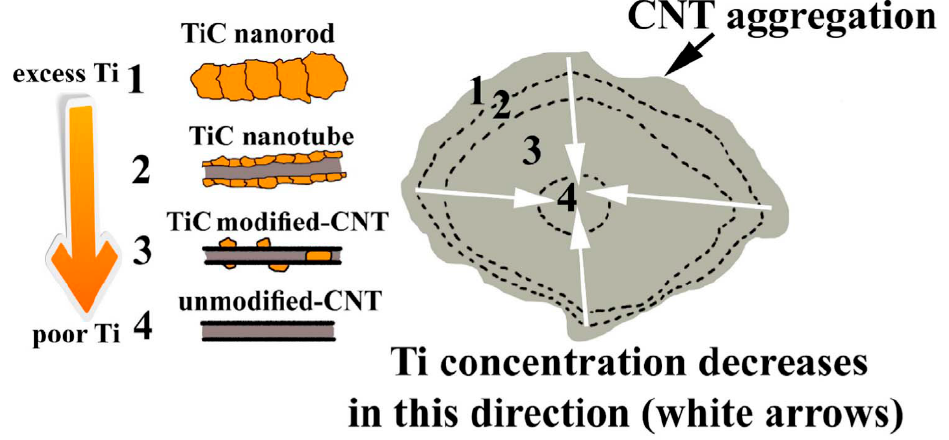
Figure 4. Schematic diagram of the formation mechanism of TiC nanorods, nanotubes and TiC-decorated CNTs. Reprinted from Ref. [55] with permission from Ceramics International.